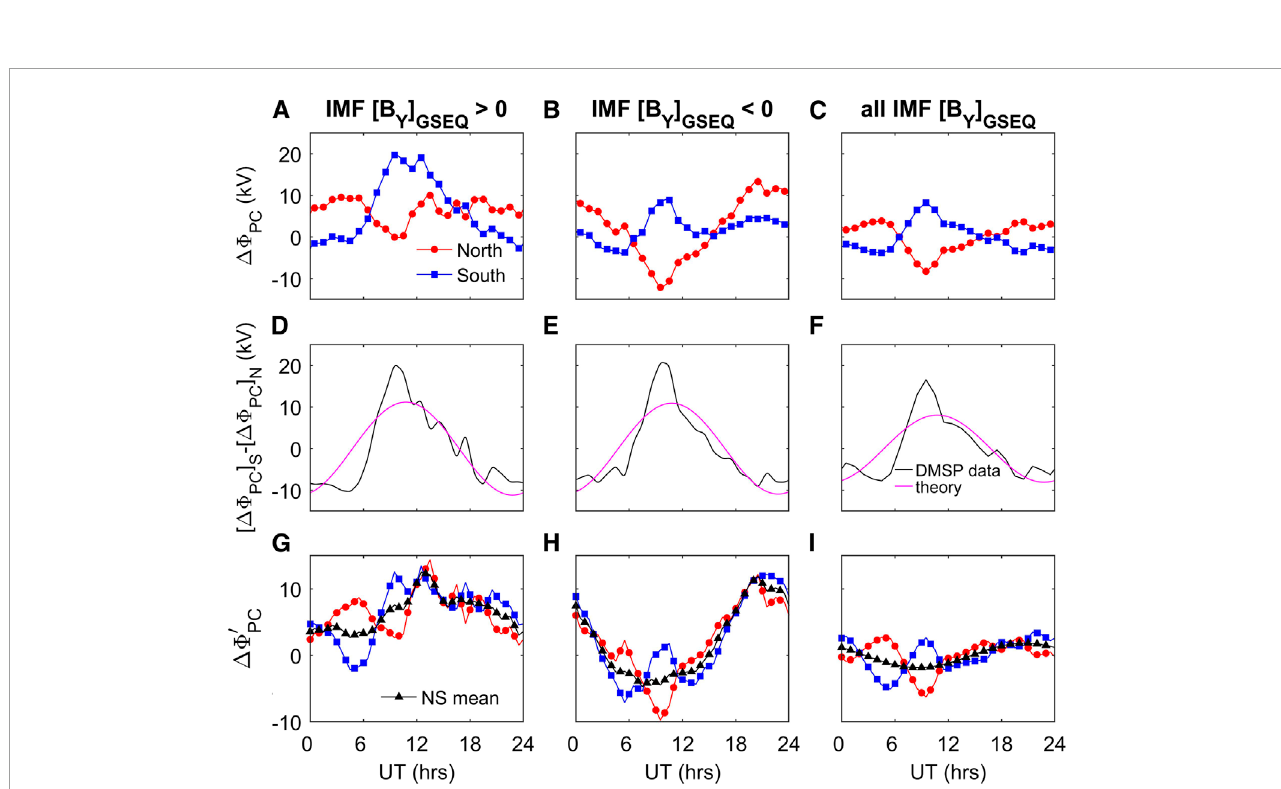
FIGURE 14 UT variations (averaged over all times of year F ) of (top row) difference in mean transpolar voltages for the data subset in question and the overall mean value at that UT ΔΦ PC ; red line with circle symbols are for the northern hemisphere transpolar voltage, [ ΔΦ PC ] N , blue lines with square symbols for the southern, [ ΔΦ PC ] S . The data are the same DMSP observations for 2001 and 2002 as in Figures 12 , 13 . (middle row) The difference between the southern and northern polar cap voltages, [ Φ PC ] S −[ Φ PC ] N (in black) and the predicted variation due to pole motions (in mauve). The effective polar cap diameters ( f c . d PC ) used to give best fit were: 1,390 km in (D) ; 1,300 km in (E) ; and 960 km in (F) (corresponding to latitudinal radii of 5.9 ° , 5.5 ° , and 4.1 ° ), these giving the minimum r.m.s. deviation of the observed and model values) (bottom row). The ΔΦ PC values after removal of the pole motion effect, ΔΦ ′ left-hand column is for [ B Y ] GSEQ > 0, the middle column for [ B Y ] GSEQ < 0 and the right hand column for all [ B Y ] GSEQ